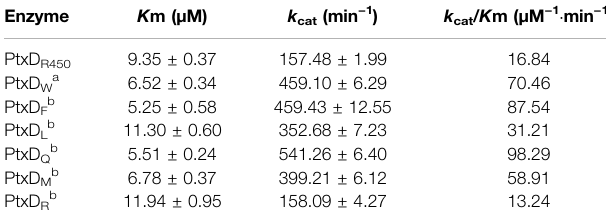
TABLE 1 | Kinetic constants with phosphite for PtxD R4506 and evolved variants.